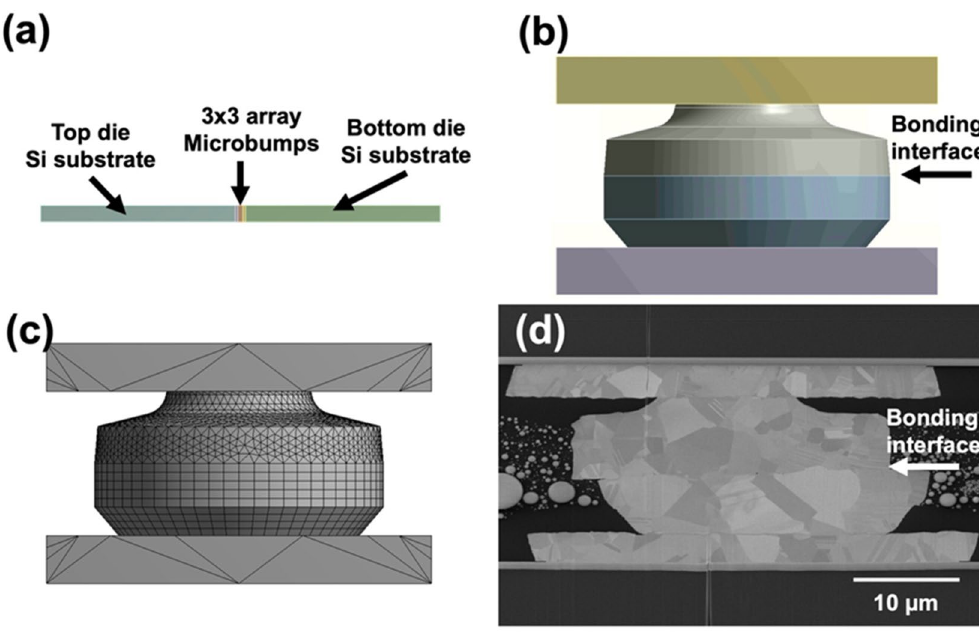
Figure 9. ( a ) 3D FEA model with 500-μm thick Si substrates at both sides. Symmetry was taken into account. ( b ) Cross-sectional view of the constructed 3D model of a single microbump. ( c ) Cross-sectional view of the model with meshing. ( d ) SEM image of the